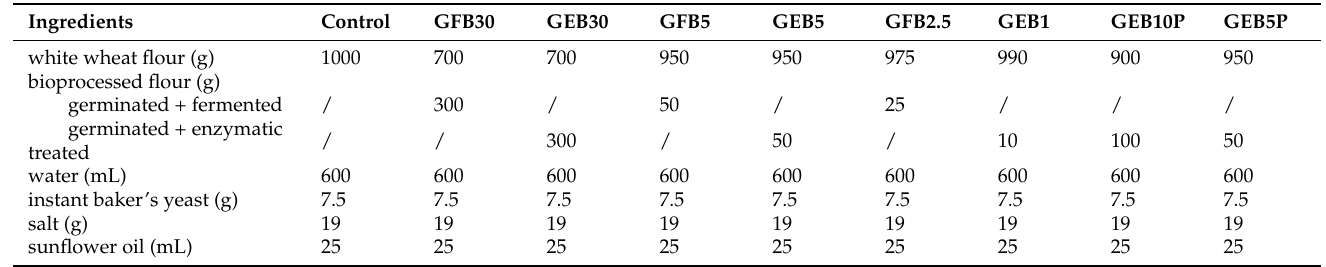
Table 5. Dough formulation of white wheat bread (control) and wheat bread enriched with biopro- cessed spelt